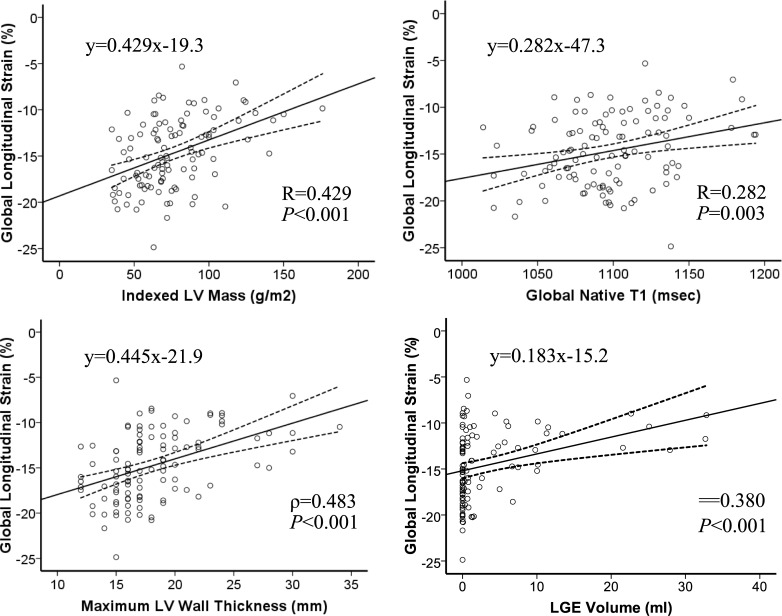
Associations of GLS, LV hypertrophy and fibrosis.Scatter plots for CMR-FT GLS and variables related to the extent of left ventricular hypertrophy and myocardial fibrosis in HCM patients. Lines indicate the best-fit line and 95% confidence interval for the mean.